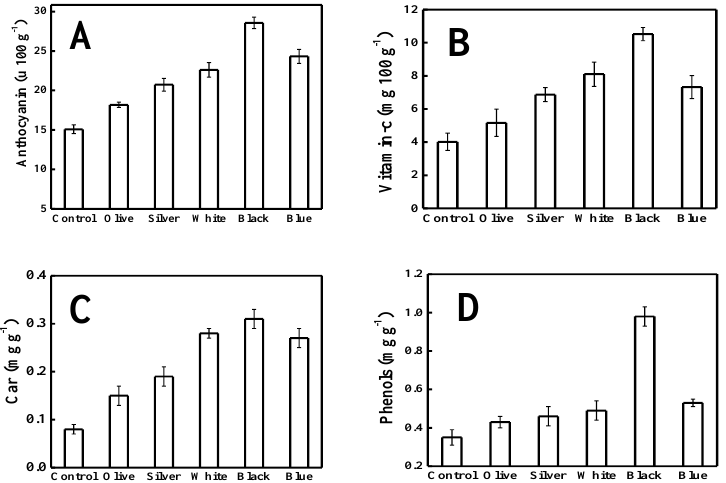
Fig. 5. Effects of different types of plastic films on chemical properties in lettuce. Each histogram represents a mean value of three independent experiments and the vertical bars indicate SE (n =